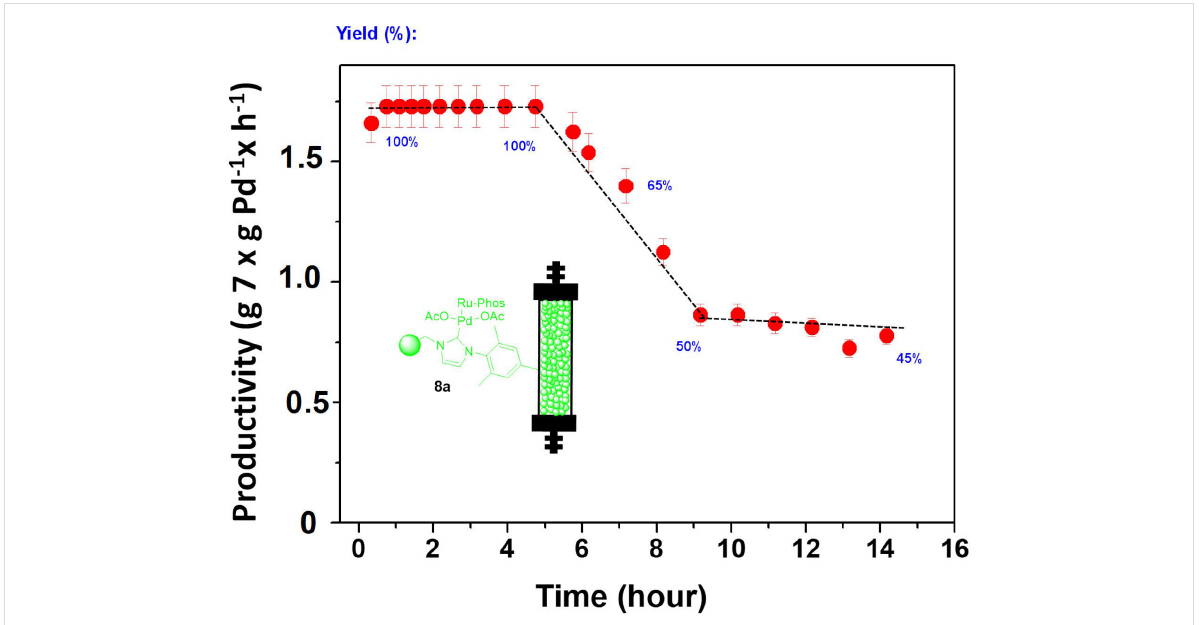
Figure 3: Negishi model reaction under flow conditions catalyzed by 8a . V = 2.9 mL, 1.25 g of catalyst, residence time = 29 min, total flow rate: 1 mL/min, productivity max: 1.73 g of 7 × g Pd − 1 × h − 1 . Yields calculated by GC and confirmed by 1 H NMR.